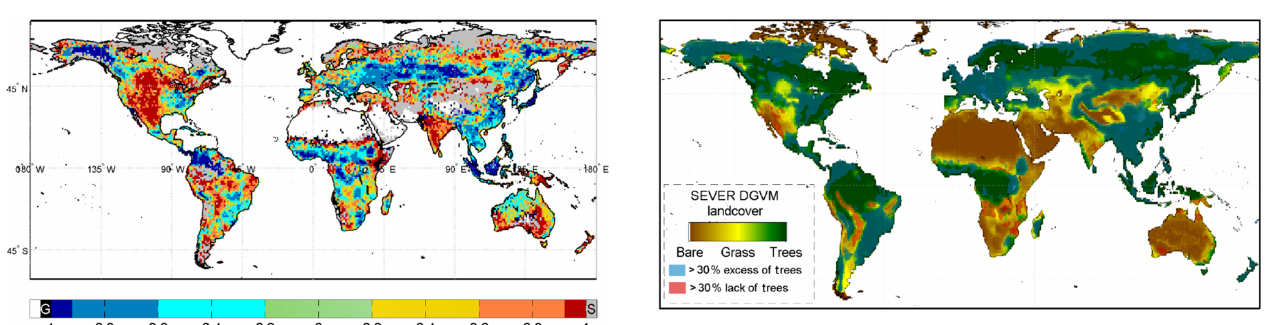
Figure 7. SEVER DGVM land cover distribution, grouped in three broad classes: bare soil, grass (C 3 and C 4 ) and trees (all tree PFTs; see Table